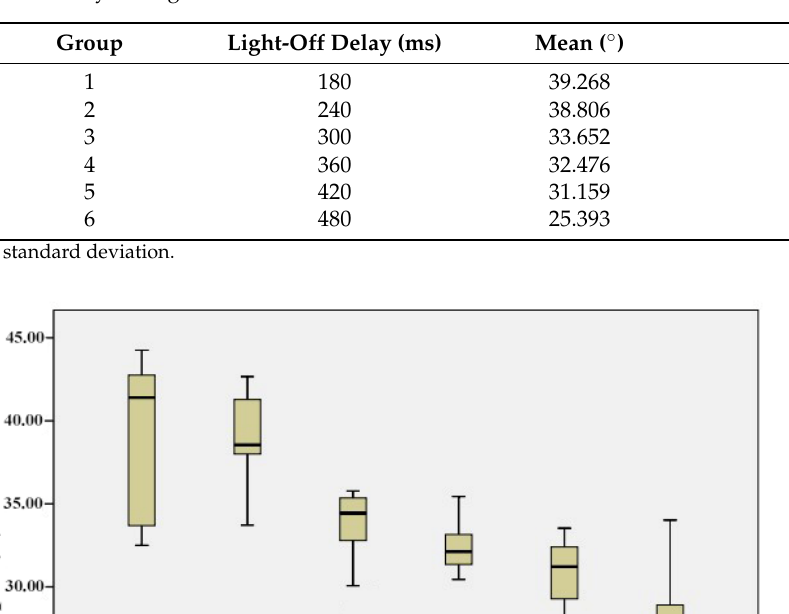
Table 1. Descriptive statistics of the taper (in ◦ ) of the tooth preparations made using different light-off delay settings.